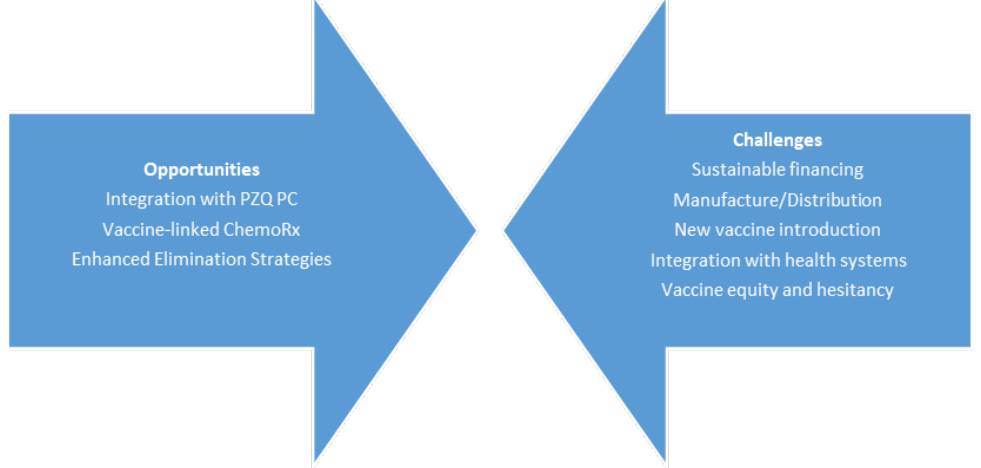
Figure 1. The opportunities versus challenges of human schistosomiasis vaccines. Abbreviations: PZQ (praziquantel), PC (preventive chemotherapy), ChemoRx (chemotherapy). A new Coalition for Epidemic Preparedness Innovations (CEPI)